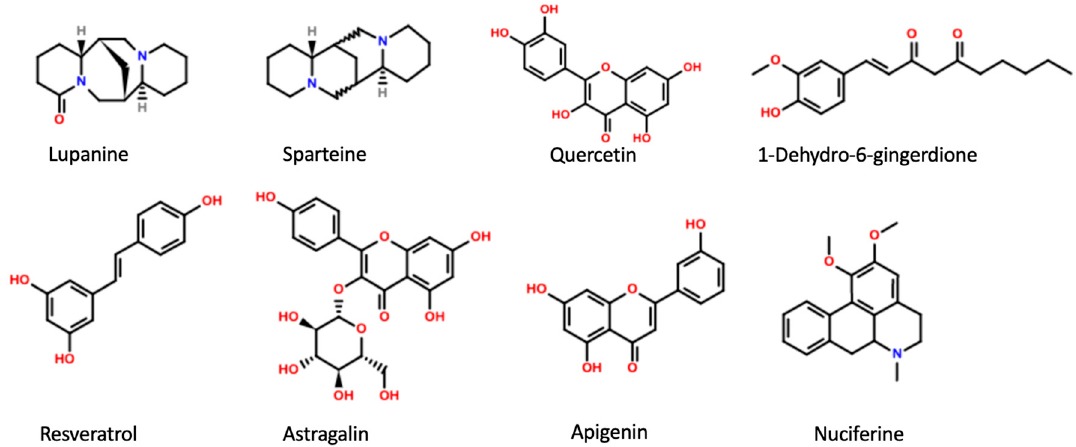
Figure 1. Main active plant constituents with inhibitory effect on K ATP channels.